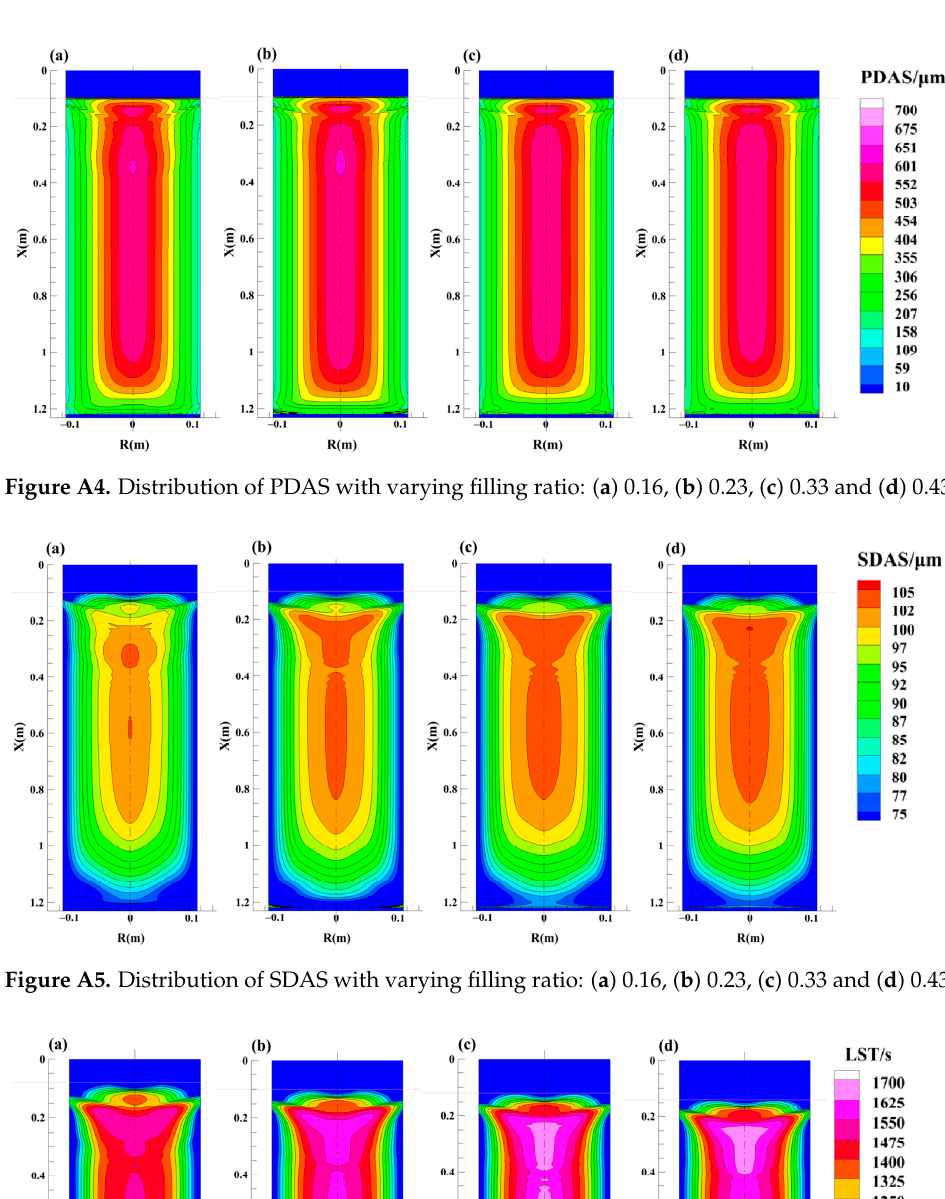
22 of 25 Figure A2. Temperature distribution (left of each figure) and liquid metal volume fraction distribu- tion (right of each figure) as varying slag thickness at end of steady-state: ( a ) 0.08 m, ( b ) 0.10 m, ( c ) 0.12 m and ( d ) 0.14 m.